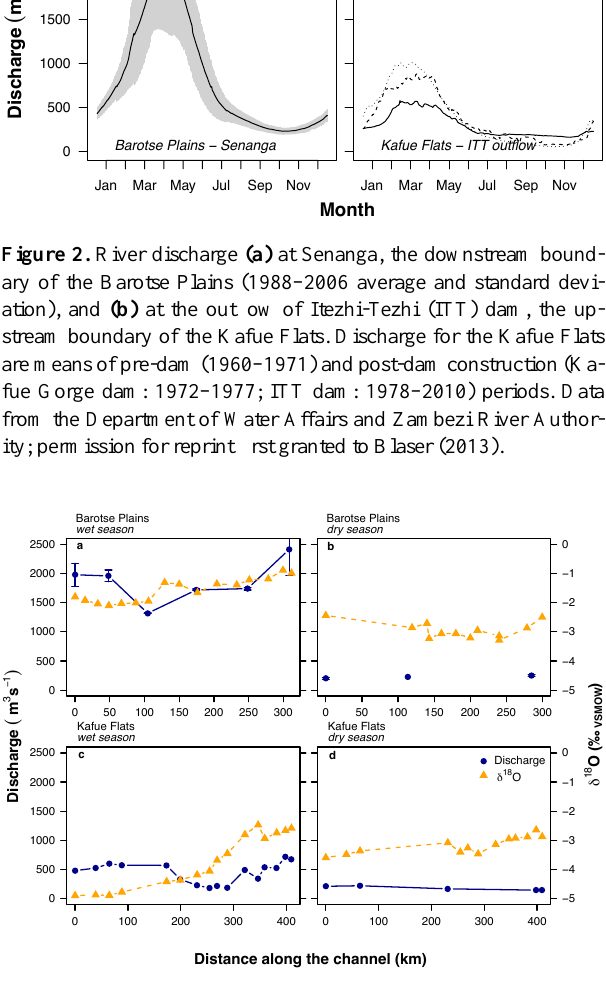
Figure 3. Discharge and stable oxygen isotope signals in the Barotse Plains and the Kafue Flats during wet and dry seasons. Dis- charge and δ 18 O data for the Kafue Flats have been published pre- viously in Zurbrügg et al.